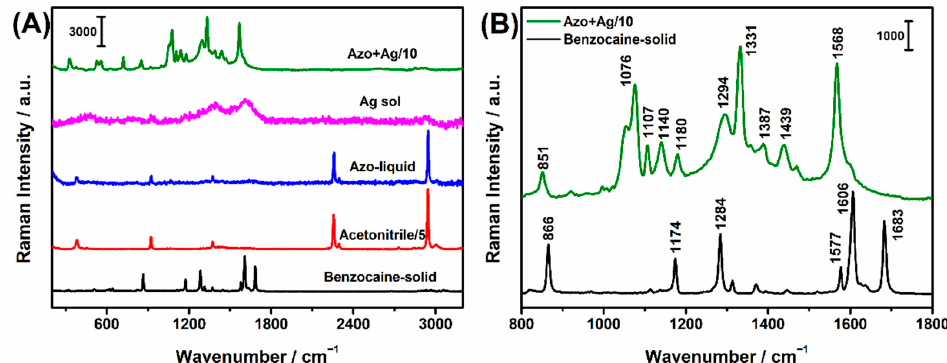
Figure 5. ( A ) Raman spectra of Ag NPs, benzocaine-derived azo solution, acetonitrile, benzocaine solid, and SERRS spectrum of benzocaine-derived azo solution. ( B ) Specific peak positions for Raman spectrum of benzocaine solid and SERRS spectrum of azo compound derived from 1 mg/mL benzocaine with Ag NPs at the volume ratio of 1:10. Excitation wavelength: 532 nm.